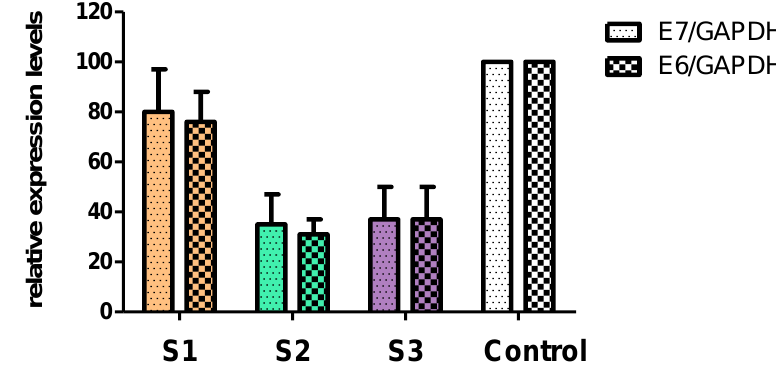
Figure 5. The influence of crude C. majus latex (S1), protein fraction (S2), and alkaloid-rich fraction (S3) on the infectivity of HPV pseudovirions in HaCaT cells. PsV-HPVs and non-toxic concentrations of crude latex, alkaloid-rich fraction, and protein fraction were added to the cells, and after 48 h of incubation the luminescence level was measured using a spectrophotometer. The luminescence intensity of a given sample corresponded to the infectivity of the virus in HaCaT cells. The lowest level of infectivity (the lowest intensity of luminescence) was observed for cells treated with the crude latex (27.5%). For the cells treated with alkaloid-rich fraction and protein fraction, the intensity of luminescence equaled 77.1% and 64.4%, respectively. S1—cells treated with crude latex, S2—cells treated with protein fraction, S3—cells treated with alkaloid-rich fraction, Control—untreated cells. * p < 0.05; *** p < 0.001.